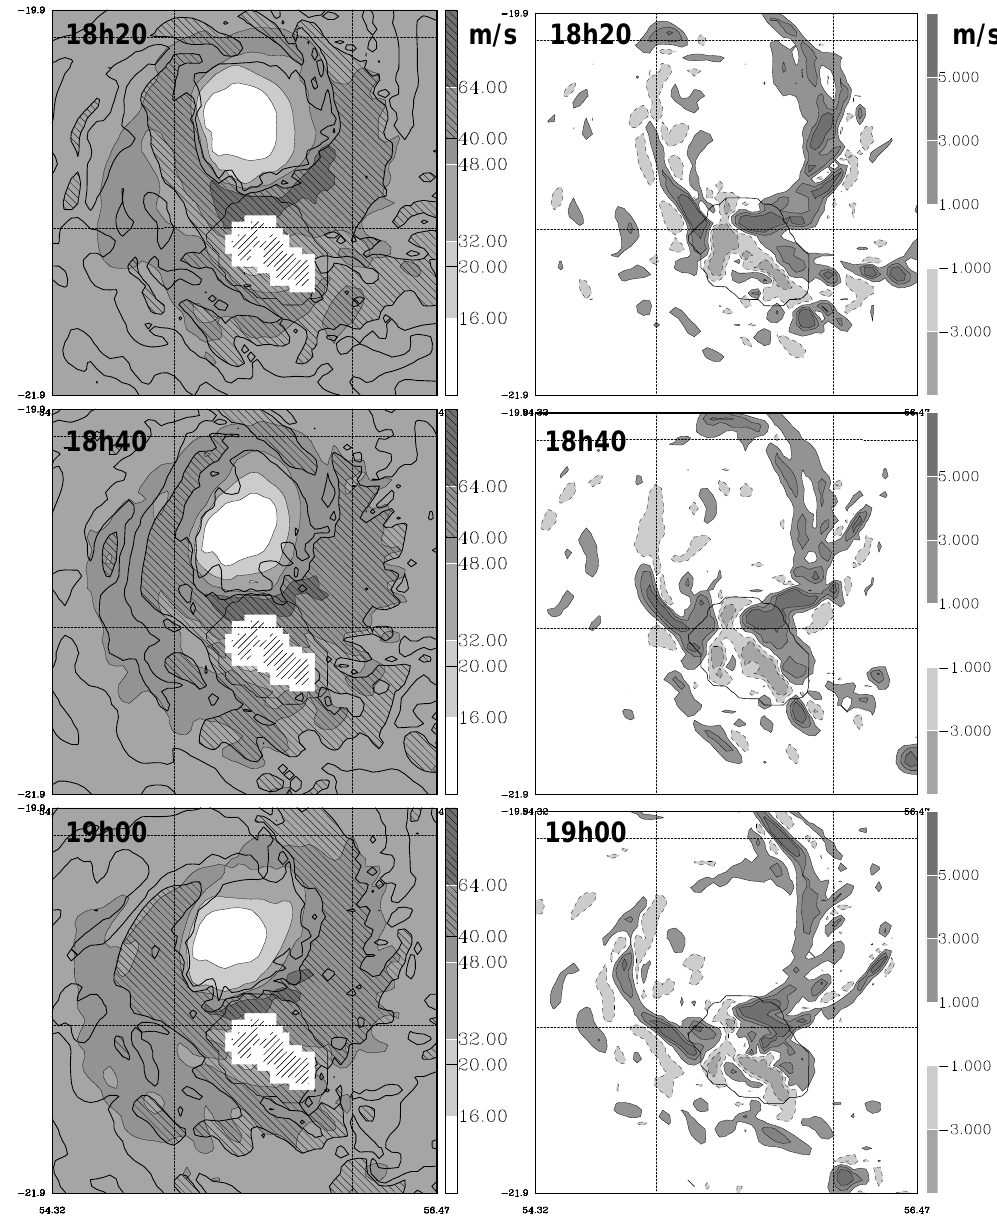
Fig. 11. Left panels: horizontal wind speed (shaded, ms − 1 ) and radar reflectivity (20 and 40dBZ contours, hatched zones denote values > 40dBZ) from the 4-km model of experiment “ Island ” at 1000m altitude, every 20min from 18:20 to 19h; right panels: as left panels, except for vertical velocity values (shaded, ms − 1 ) at 5000m